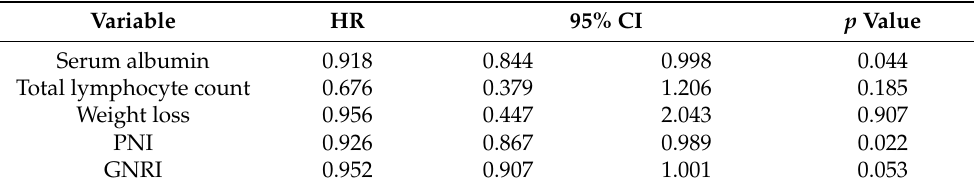
Table 3. Cox regression analysis of nutritional indices to predict all-cause mortality.